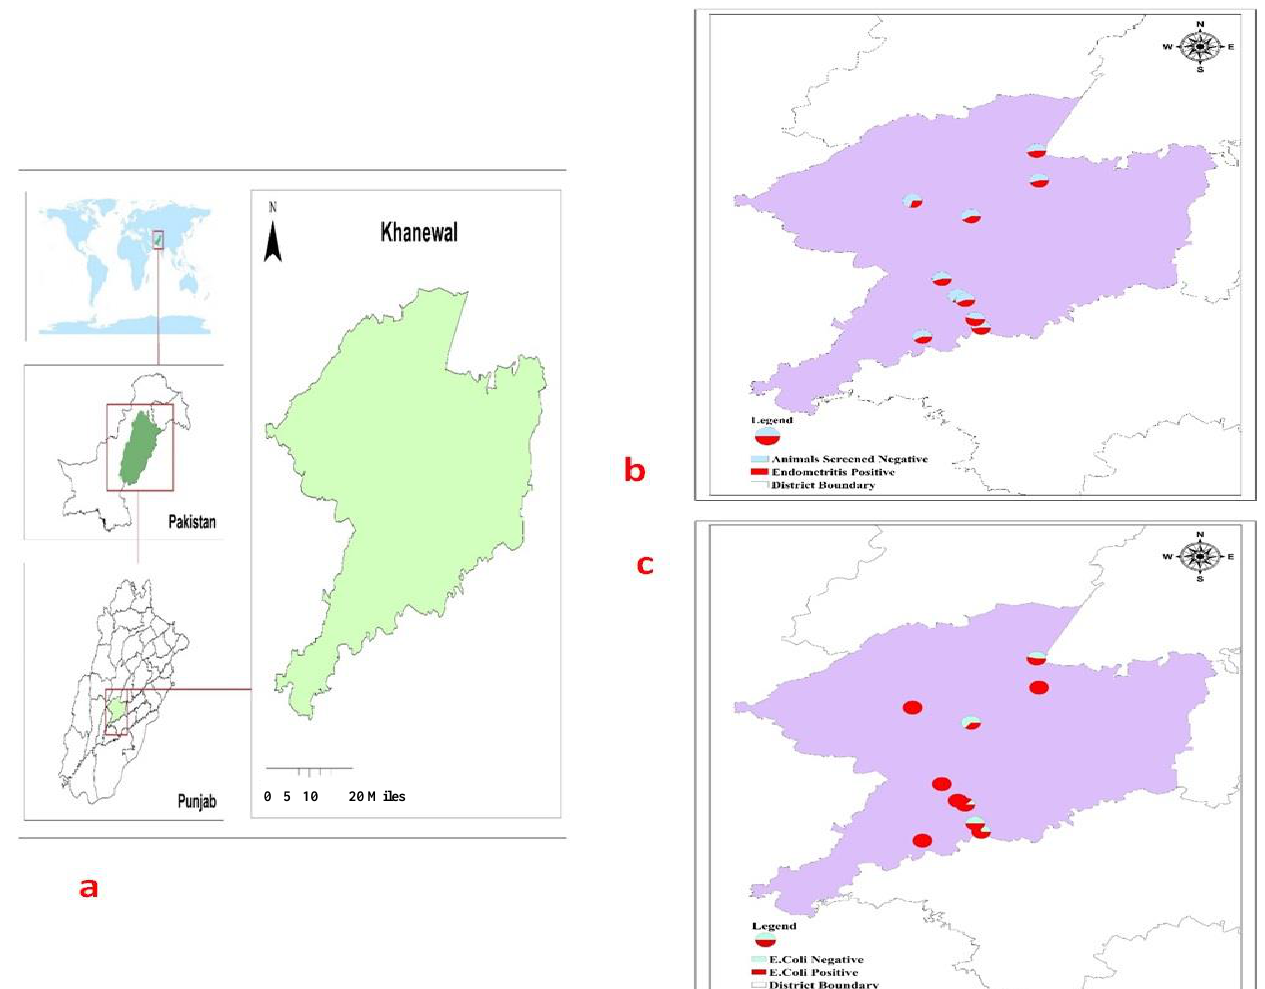
Figure 1. Tracking maps of study area, endometritis, and E. coli. ( a ) Green map indicates area of study from where samples were collected. ( b ) Number of positive endometritis cases indicated in red in the circles. Each circle is a complete farm. ( c ) Prevalence of E. coli indicated in red (circle). Each circle indicates individual dairy farm. Red area of the circle is indicative of positive